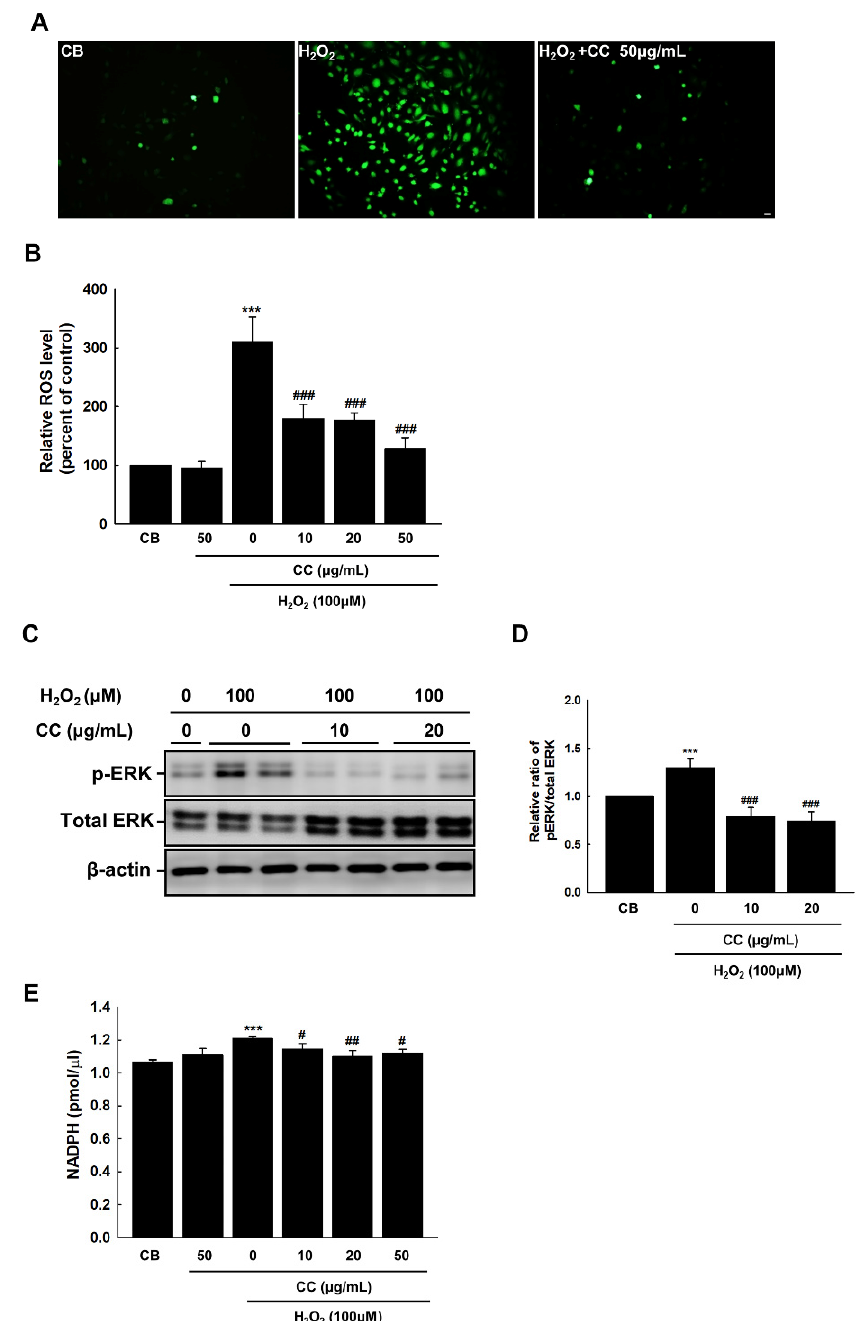
Figure 2. Chrysanthemum coronarium L. (CC) extract reduces endothelial senescence in HUVECs induced by ROS. ( A ) Fluorescent staining images illustrating ROS production in HUVECs via DCF- DA staining. The relative ratios of DCF-DA fluorescence intensities indicate the degree of endothelial ROS formation in HUVECs. The original magnification was set to 20 × . Scale bar = 50 µ m. ( B ) The fluorescence sensitivity of DCF-DA was standardized for the total number of cells in each dish. ( C – D ) Expression of phospho-ERK, total ERK, and β -actin in H 2 O 2 -treated cells. ( E ) NADPH was measured using a colorimetric assay. Control cells (CB) received the vehicle alone. Bars represent the mean ± SEM from three dishes per group. ***, p < 0.001, versus CB; #, p < 0.05, ##, p < 0.01, ###, p < 0.001, vs. H 2 O 2 .